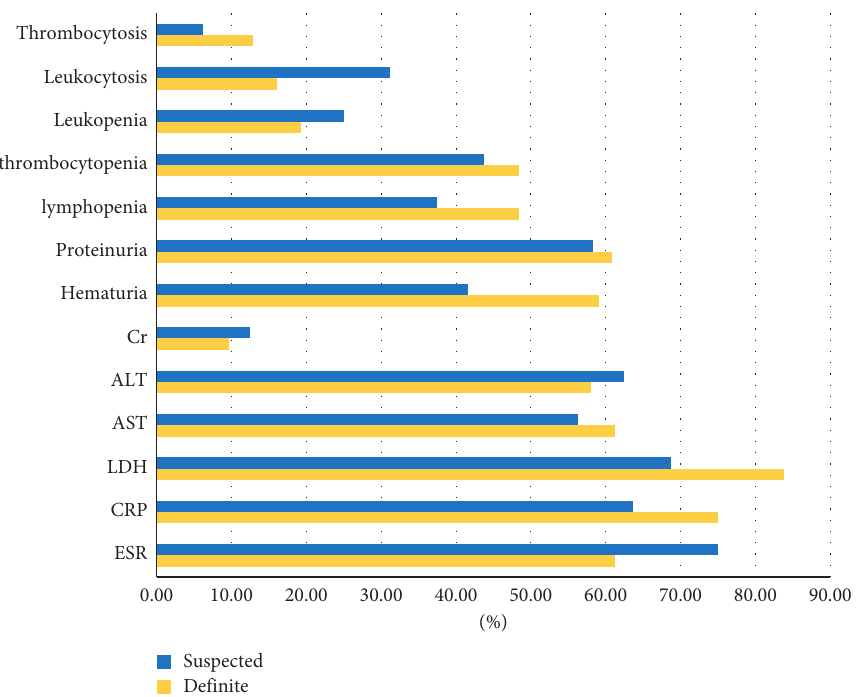
Figure 2: Percentage of abnormal initial tests in the definite and suspected groups. Table 4: Reasons for death in COVID-19-infected